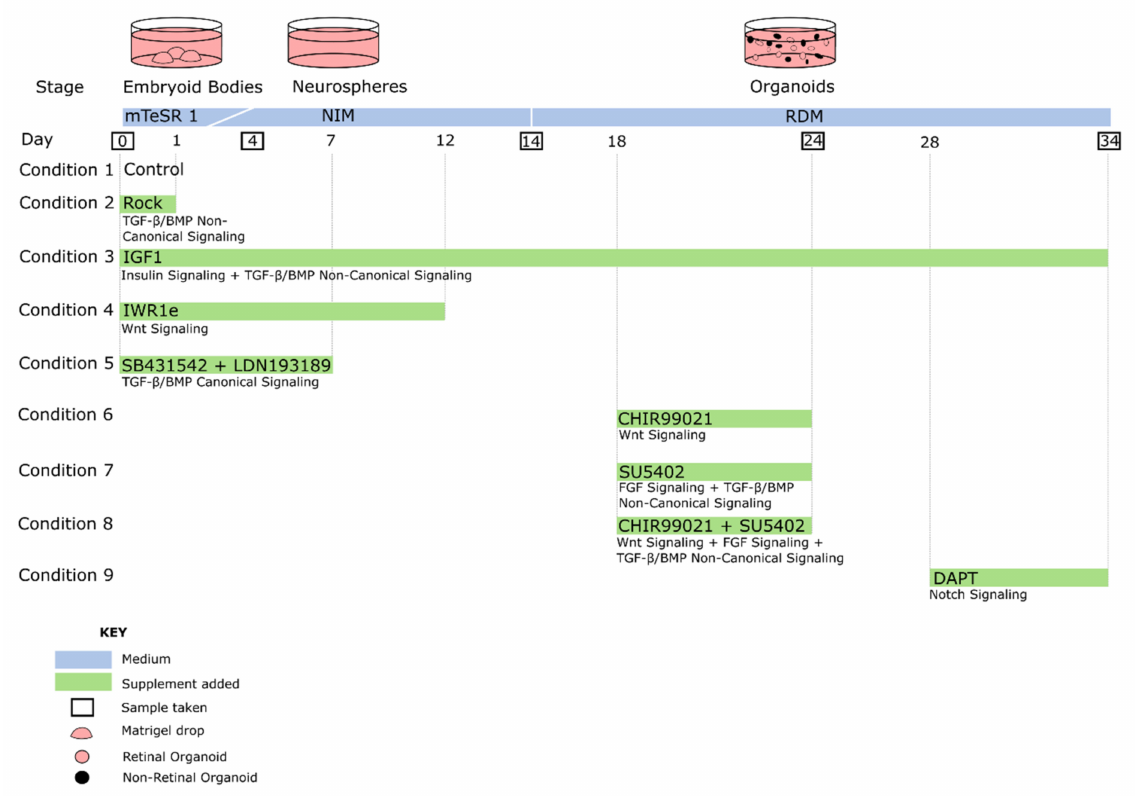
Figure 9. Experimental outline of pilot. A collection of frequently used agonists and antagonists for different signaling pathways reviewed in this article were systematically tested for their efficiency at directing retinal development.